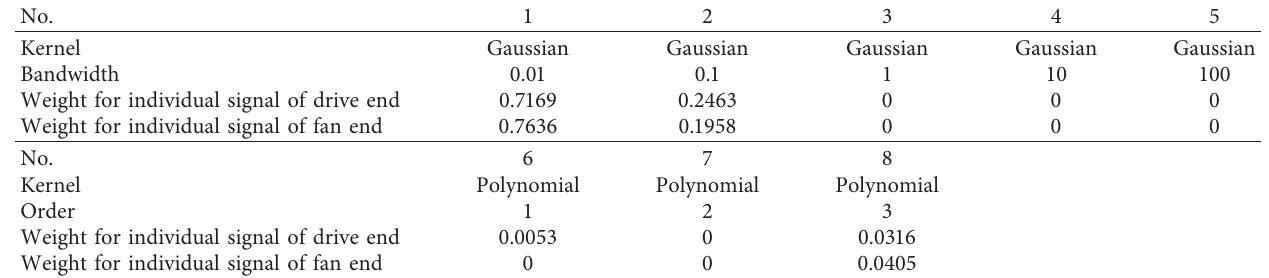
Table 5: Multikernel parameters for individual signal model.